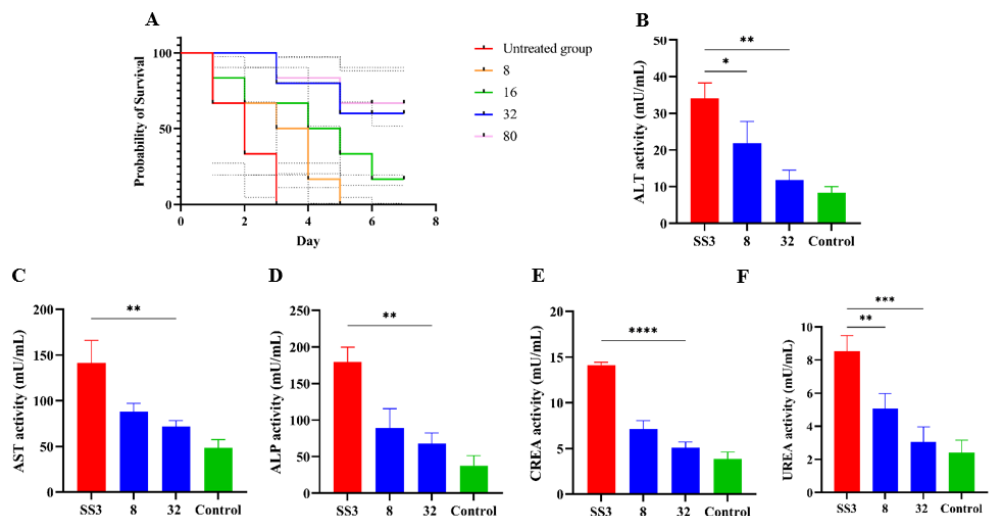
Figure 5. The efficacy of IBG against S. suis in vivo. ( A ) The survival curve of various concentrations of IBG cured S. suis SS3-infected mice model. Blood levels of ( B ) ALT, ( C ) AST, ( D ) ALP, ( E ) CREA, and ( F ) UREA in mice. SS3 is the infected group; eight were in the treated group with 8 µg/mL IBG, and 16 were in the treated group with 16 µg/mL IBG; Control is the blank group without any treatment. *, p < 0.01, **, p < 0.01, ***, p < 0.001, ****, p < 0.0001.